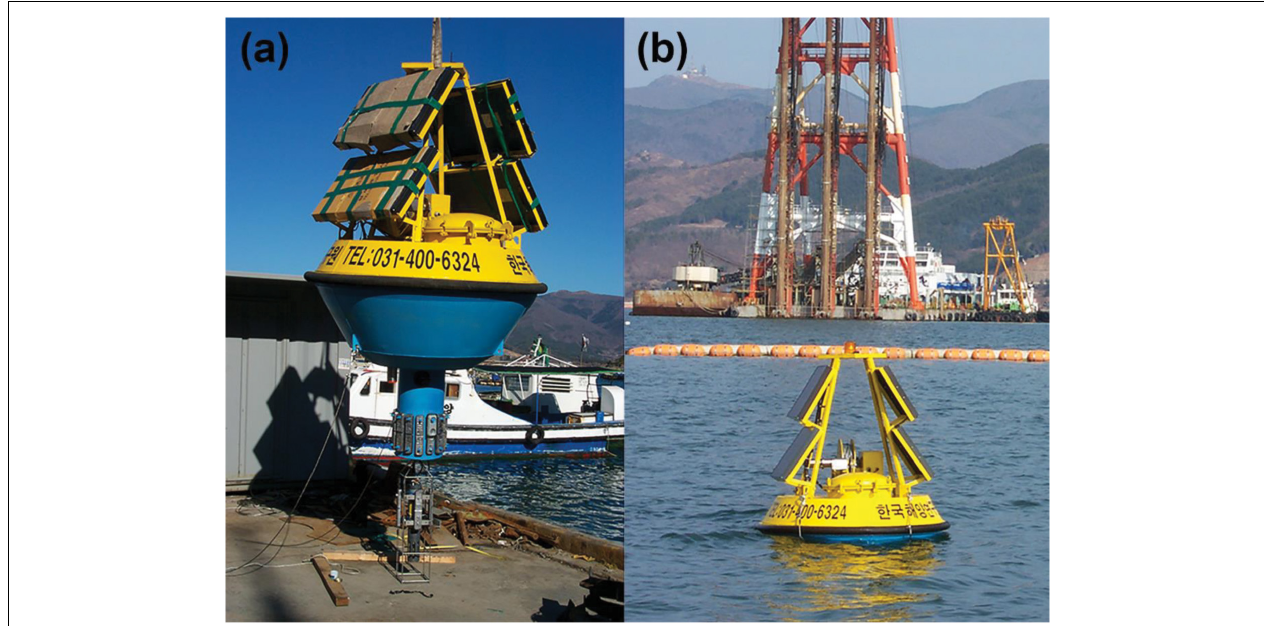
FIGURE 1 | (a) Photograph of Intelligent Buoy System (INBUS)-1 before mooring, (b) photograph of INBUS-1 after mooring.